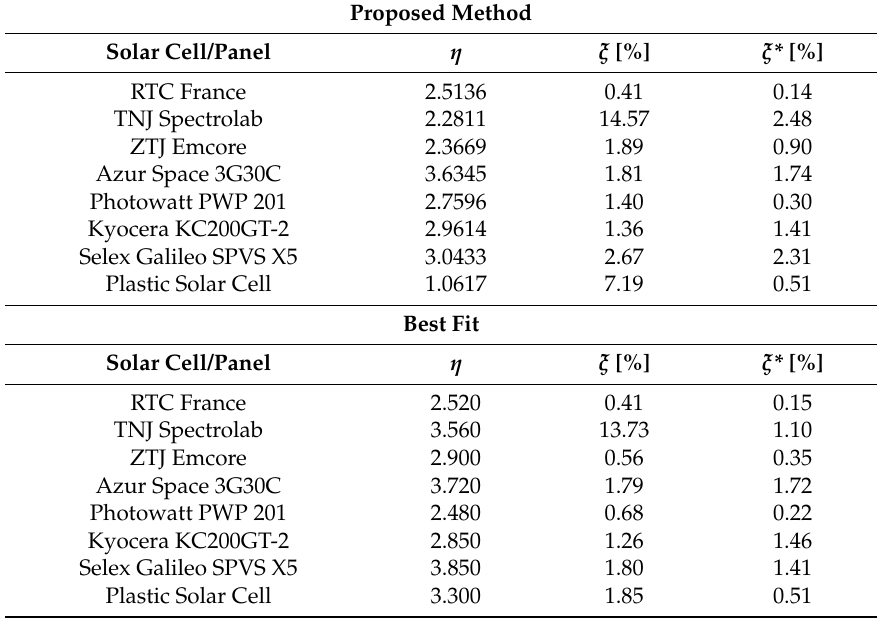
Table 8. Parameters from Pindado and Cubas’s explicit model (Equation (34)), fitted to the I-V curves for the photovoltaic devices studied (see Table 1). The fittings were performed numerically (Best fit), and using the proposed method (Equation (35)). The normalized RMSE values of the fittings, ξ , and ξ * , are included in the